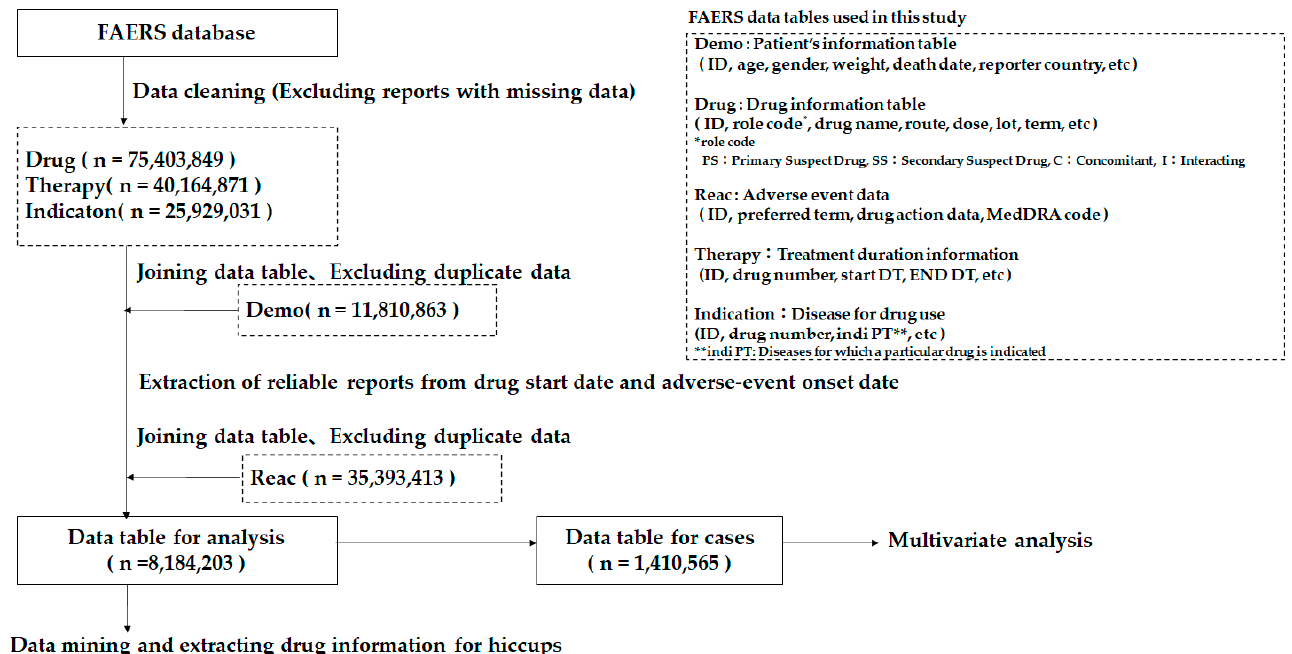
Figure 6. Production of a data analysis table.